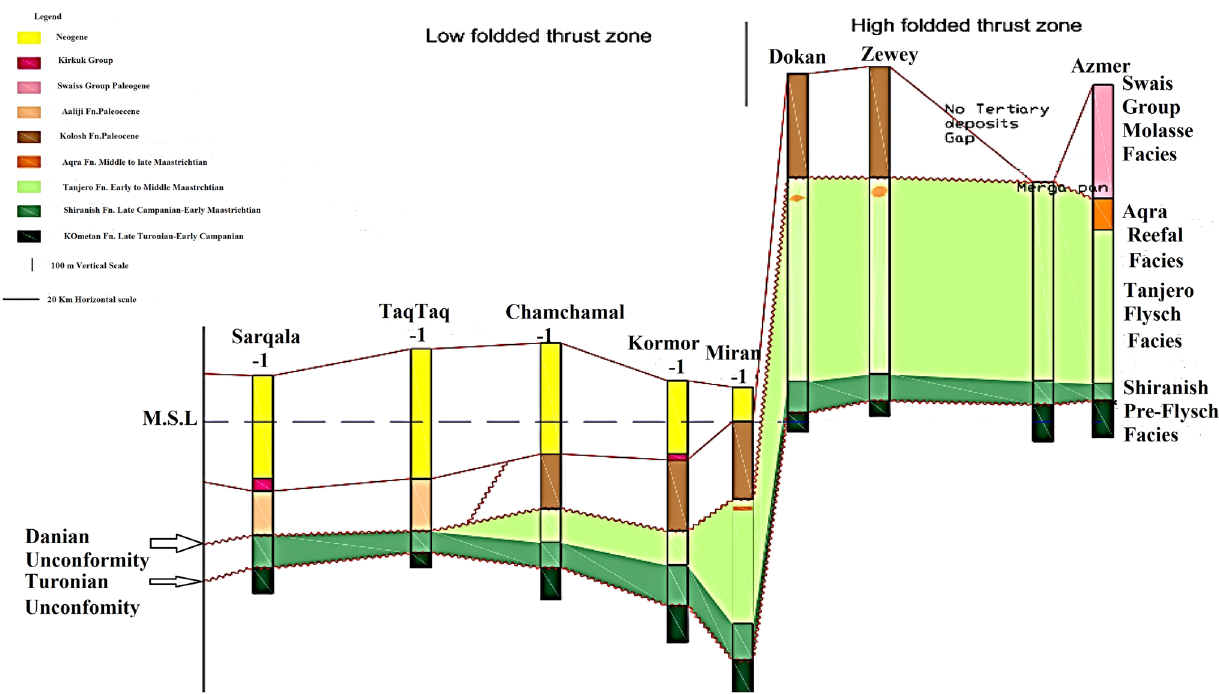
Fig. 9 Lateral and vertical lithostratigraphic variations in the studied sections and